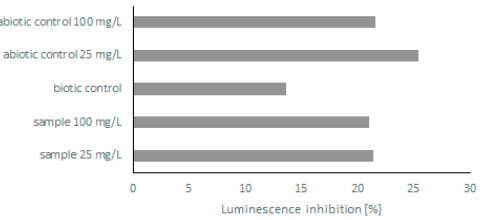
Figure 4. Bioluminescence reduction by abiotic control and post-culture liquids obtained after 48 h of incubation of C. lunata IM 4417 with quinoline.